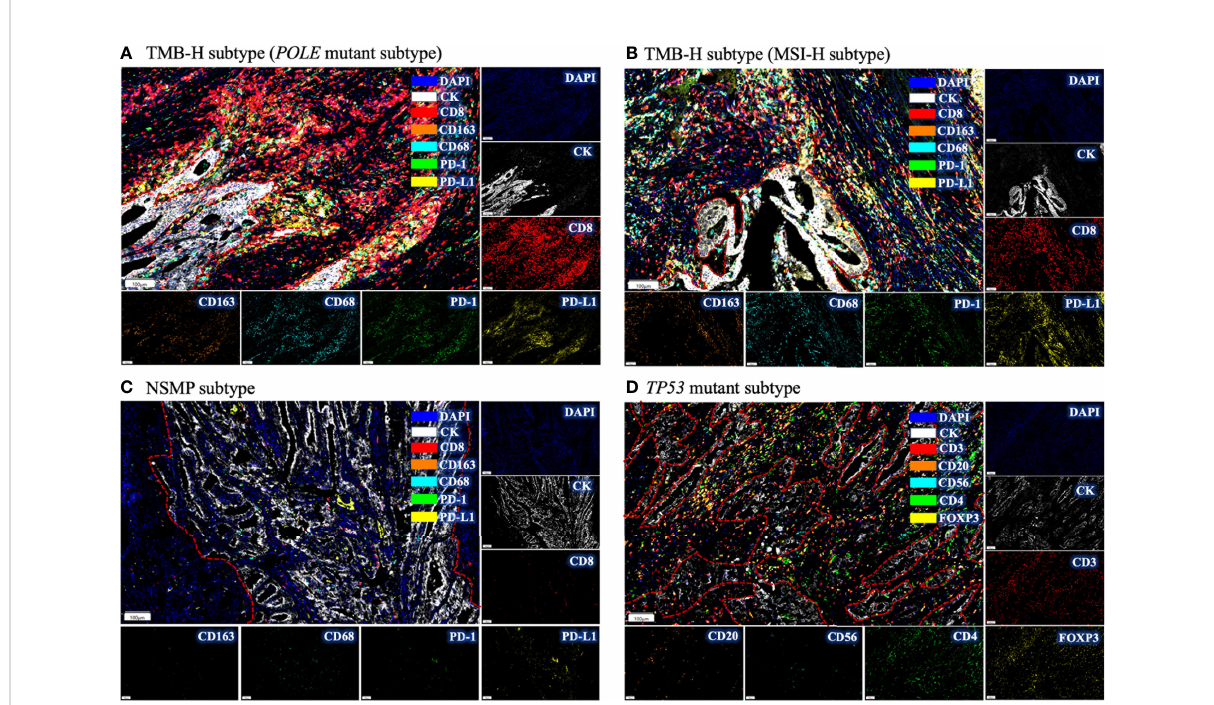
FIGURE 3 Immune in fi ltration in different molecular subtypes of EC by multiplex immuno fl uorescence. (A) The immune in fi ltrations in EC of POLE mutant subtype. Intense red fl uorescence indicates large amount of CD8 + cell in fi ltration. (B) The immune in fi ltration in EC of MSI-H subtype. (C) The immune in fi ltration in NSMP subtype. Few fl uorescence signals could be observed, indicating absence of immune in fi ltration. (D) The immune in fi ltration in TP53 mutant subtype. Intense yellow fl uorescence indicates the in fi ltration of FOXP3 + cells. For each subtype, a representative fi led was selected, and the major tumor regions are outlined. TMB-H, high tumor mutation burden; MSI-H, microsatellite instability high; NSMP, no speci fi c molecular pro fi le; EC, endometrial